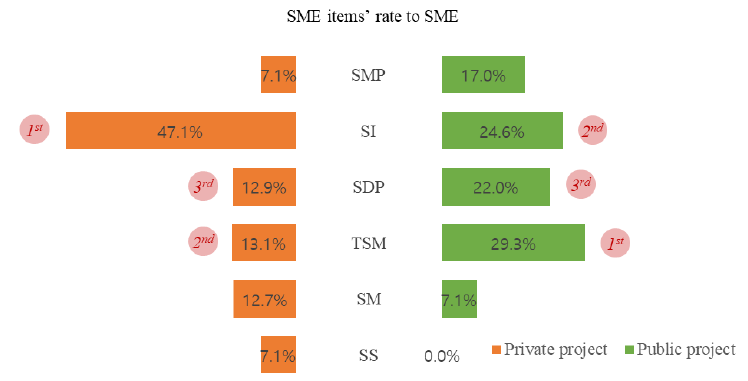
Figure 8. Rates of SME items to SME for different client types.